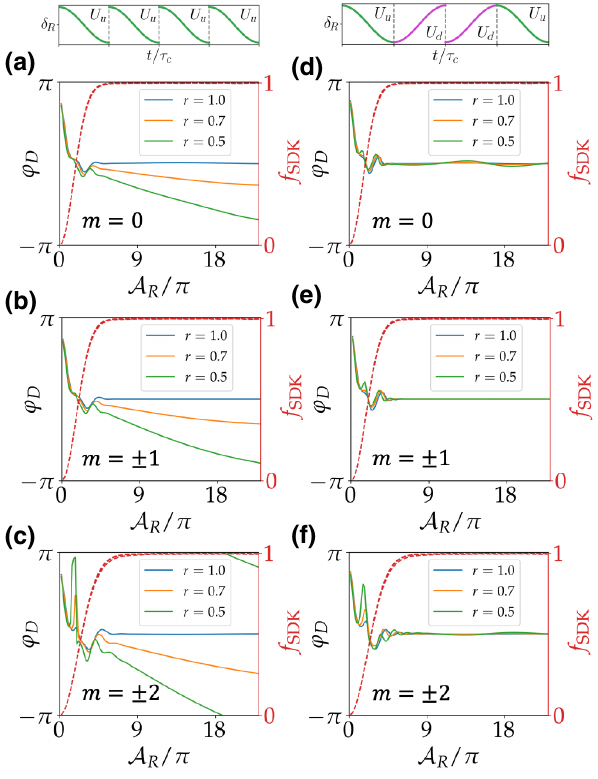
FIG. 8. Unbalanced dynamic phase ϕ D = ϕ ( 4 ) Eq. (9) versus pulse area A R for m = 0 (a),(d), m = ± 1 (b),(e) and m = ± 2 (c),(f) subjected to ˜ U ( 4 ) (right) controls. The corresponding two-photon detuning profiles are illustrated on top of (a),(d). Parameters for the simulations are according to the experimental Sec. III C, except here the mir- ror reflectivity r varies. The red dashed lines give f SDK for single kicks (different r curves closely